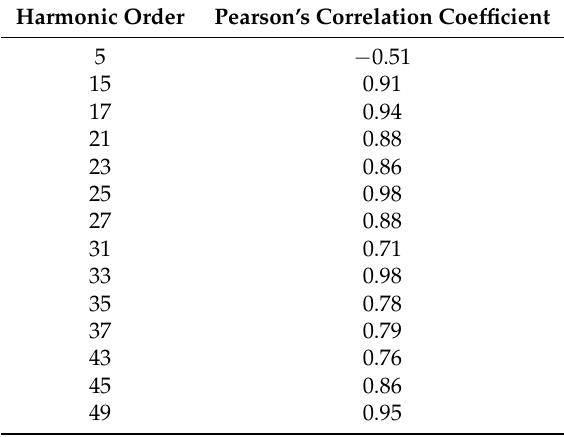
Table 2. Correlation analysis of fundamental harmonics.